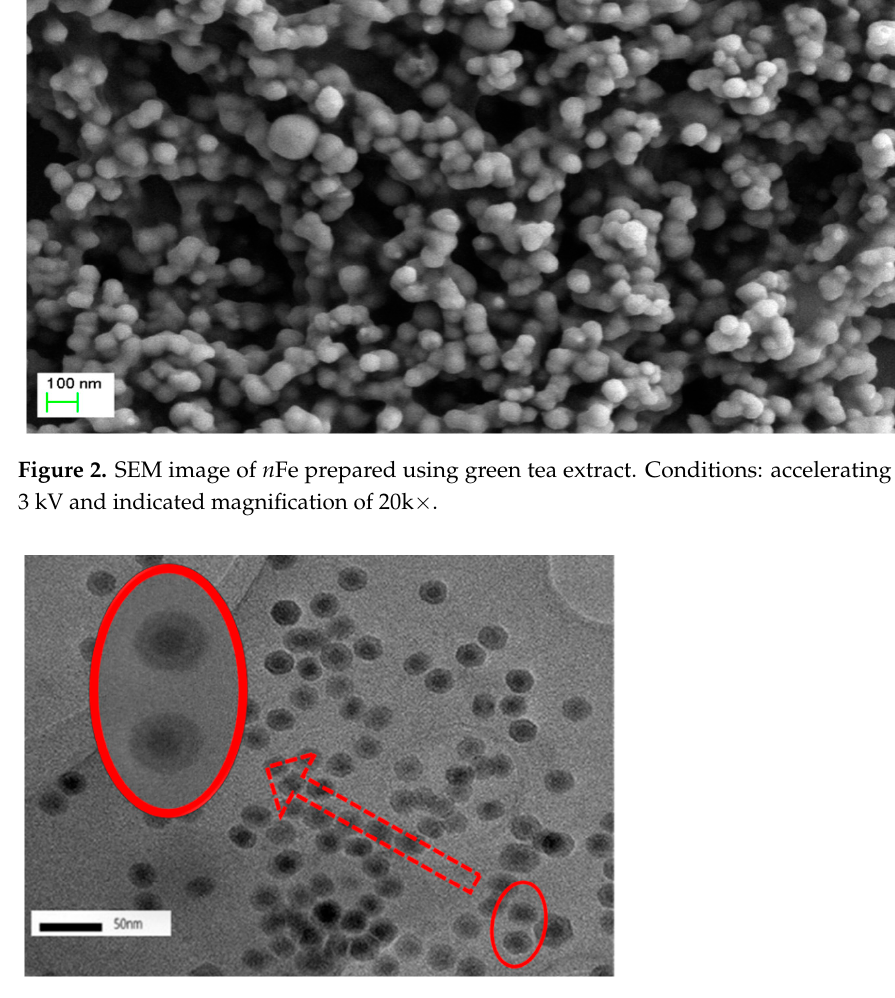
Figure 3. TEM images of n Fe. Conditions: accelerating voltage of 200 kV, indicated magnification of 100k×.